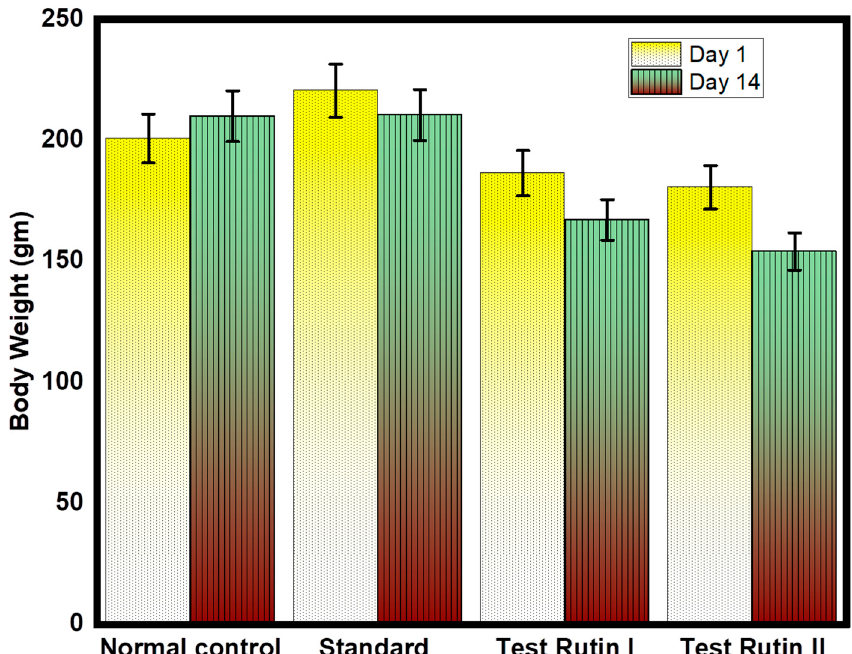
Figure 1. Effect of rutin pretreatment is compared to the initial and final weight of the rat. The results are expressed as mean ± SD values ( n = 6). The significance of the difference was determined by one-way ANOVA; * p < 0.05 vs. respective controls.